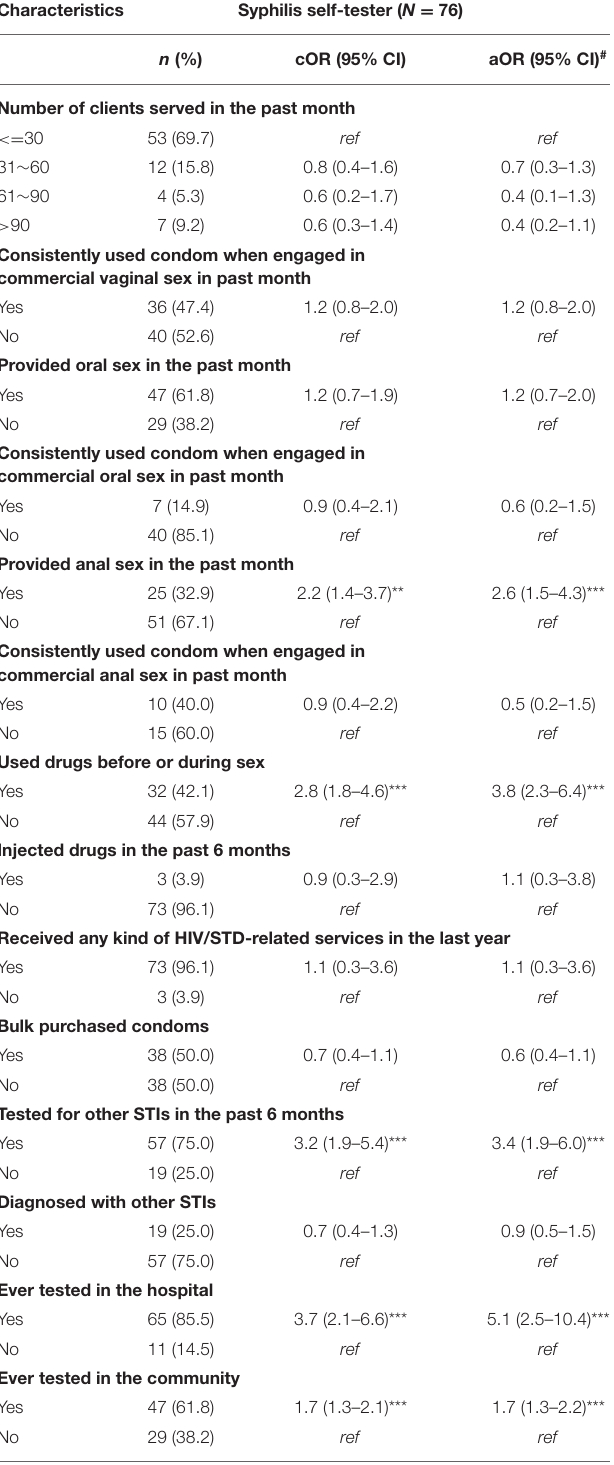
TABLE 4 | Factors correlated with self-testing among Chinese female sex workers, 2019.